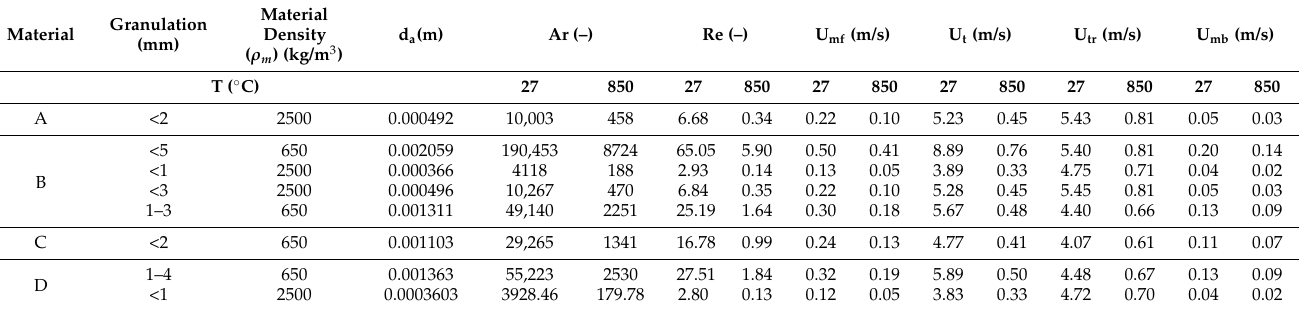
Table 4. Results of calculations of fluidization